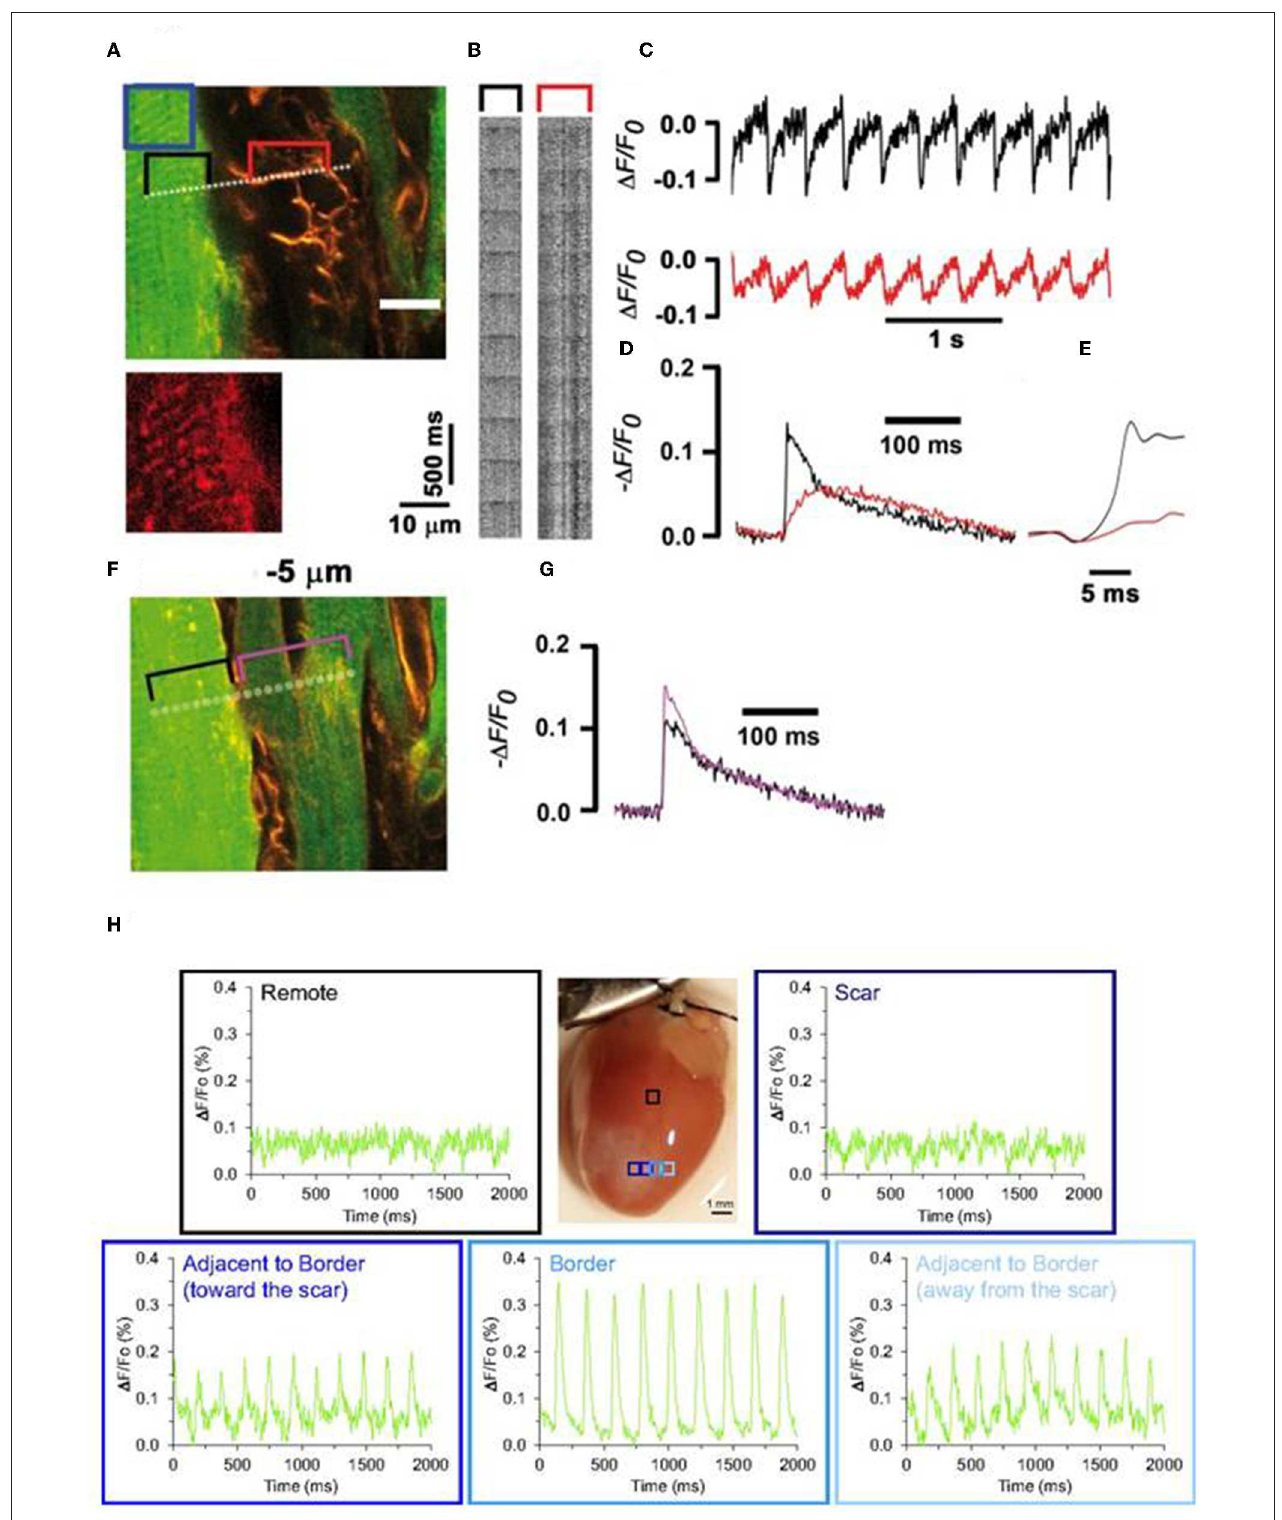
FIGURE 9 | Entrainment of the membrane potential of non-cardiomyocytes by ventricular cardiomyocytes in an infarct border of a Langendorff-perfused mouse heart (A–G) . Mouse hearts were genetically engineered to express cardiomyocyte-specific EGFP to identify cardiomyocytes from non-cardiomyocytes. Prior two-photon